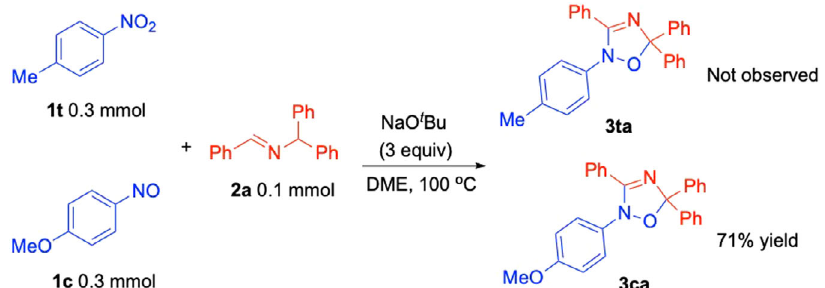
Fig. 10 Competition reaction with nitrosoarene. Product 3ca is consistent with the intermediacy of the nitrosoarene in the net [3 + 2] reaction. Similar results were obtained with 4-nitro anisole and 4-nitrosotoluene, which gave 3ta